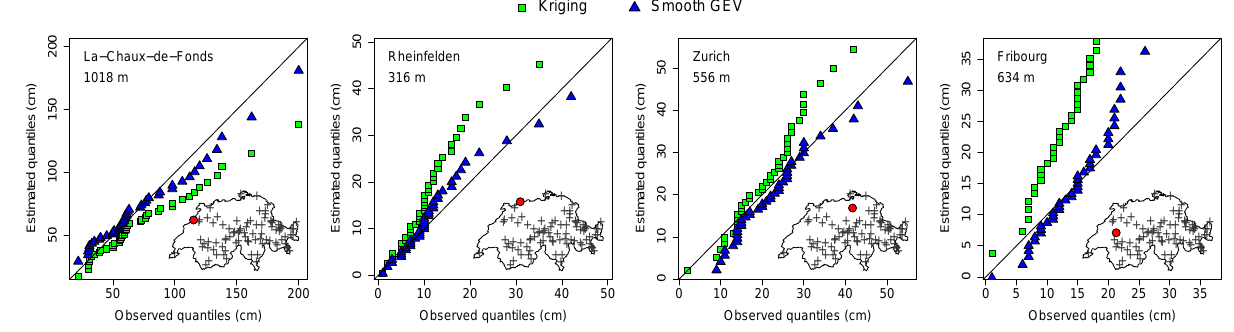
Fig. 5. QQ-plots of all four validation stations located in the Plateau, with kriging interpolation (green squares) and smooth GEV fitting (blue triangles). With both methods, longitude, latitude and elevation are used as covariates for the GEV parameters. The kriged mean snow depth is an additional covariate for the location and scale. Kriging interpolation is related to section 5. Smooth GEV fitting is related to section 6.